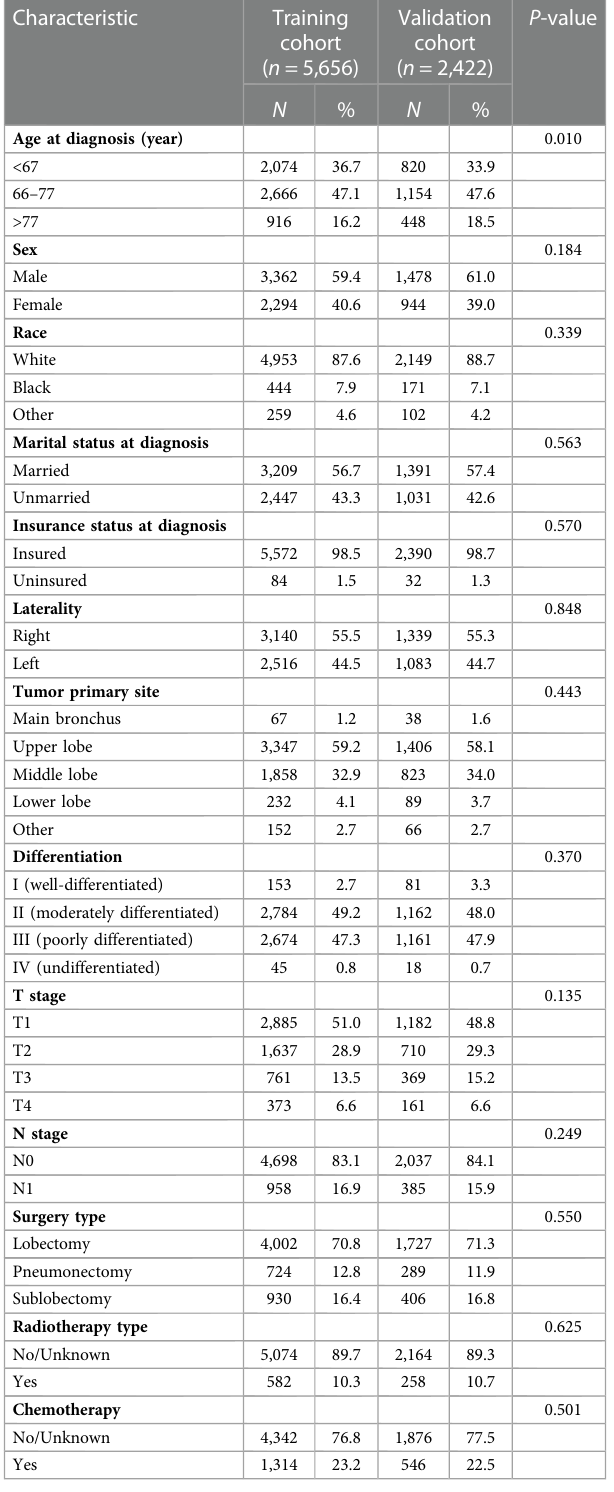
Table S1 . Patient demographic and clinicopathological